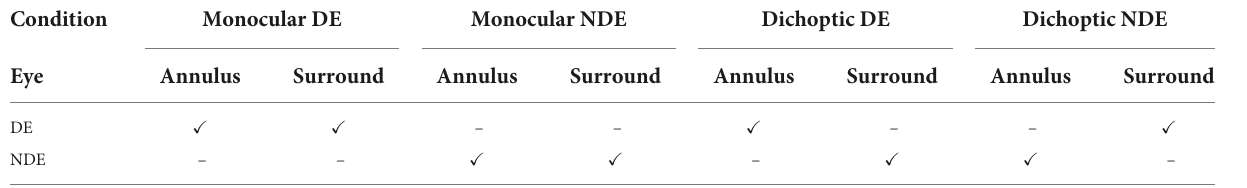
TABLE 2 Schematic of surround suppression presentation